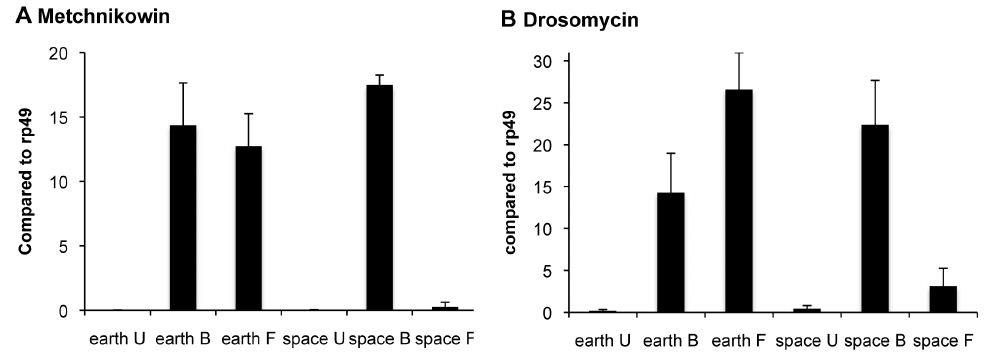
Figure 3. Antifungal AMPs. A. Metchnikowin and B. Drosomycin transcript levels were assessed by qPCR in space and Earth flies infected with fungus (F) or bacteria (B), or uninfected (U), and standardized by comparison to the level of ribosomal protein gene rp49 . Error bars=SEM for 3 experiments.